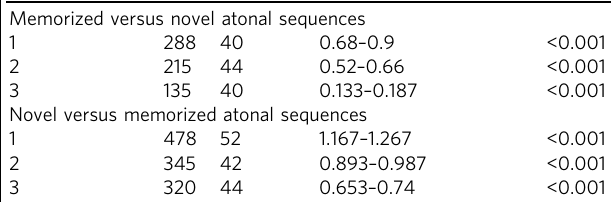
Table 2 Signi fi cant clusters of activity for the tonal MEG sensor